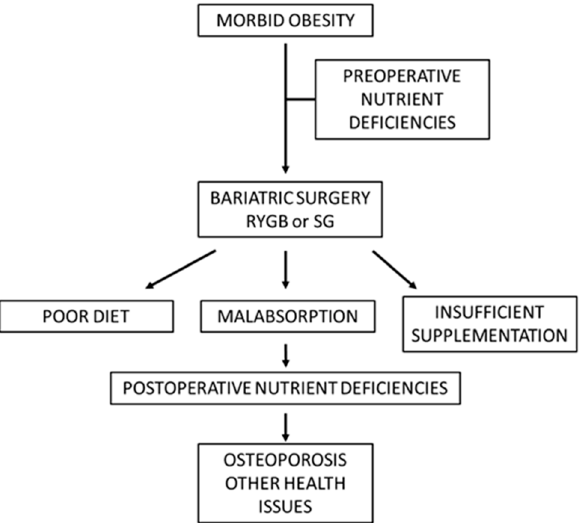
Figure 1. Postoperative development of nutrient deficiencies complicated with bone loss and/or other health issues (schematic). Among other health issues are anemia, fatigue, poor wound healing, hair loss, and neurological symptoms.